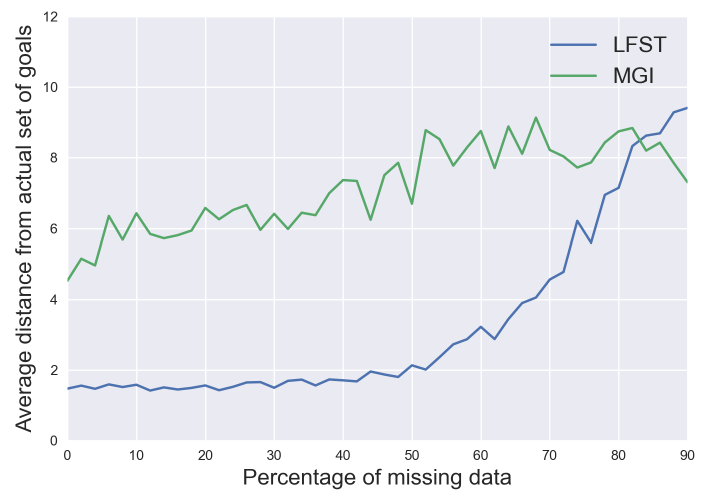
Figure 8. Comparison of the average distance from the actual goals in